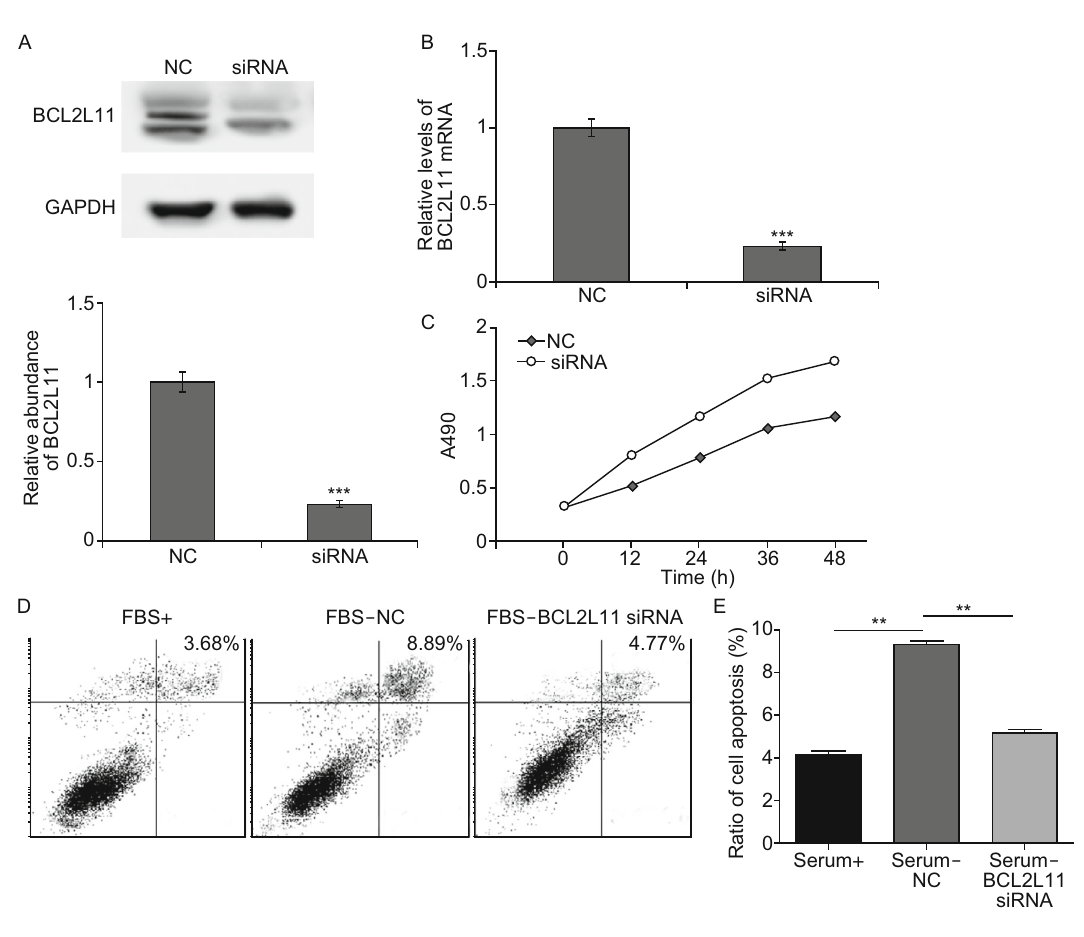
Figure 5. Knock-down of BCL2L11 in SGC7901 cells. (A and B) Silencing of BCL2L11 expression by siRNA. SGC7901 cells were transfected with BCL2L11 siRNA, and the protein levels (A) and mRNA levels (B) were detected respectively. (C) Knock-down of BCL2L11 strongly enhances cell growth in GC cells. (D and E) Silencing of BCL2L11 clearly reduces cell apoptosis of SGC7901 cells. ** indicates P < 0.01; *** indicated P